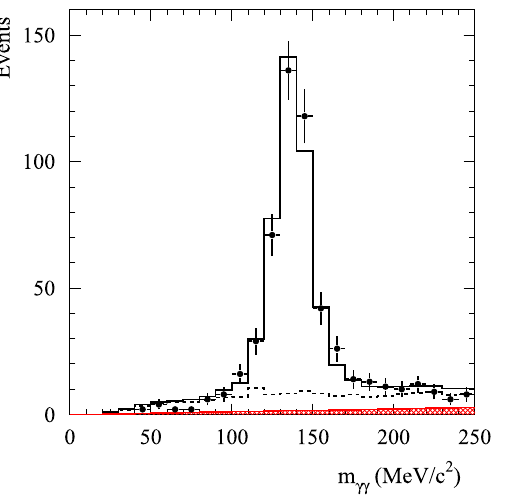
Fig. 4 The P max distribution for selected data events and simulated events of the process under study and background √ s = 1 . 89 GeV. processes at The vertical line indicates the boundary of the condition P max > 500 MeV/ c